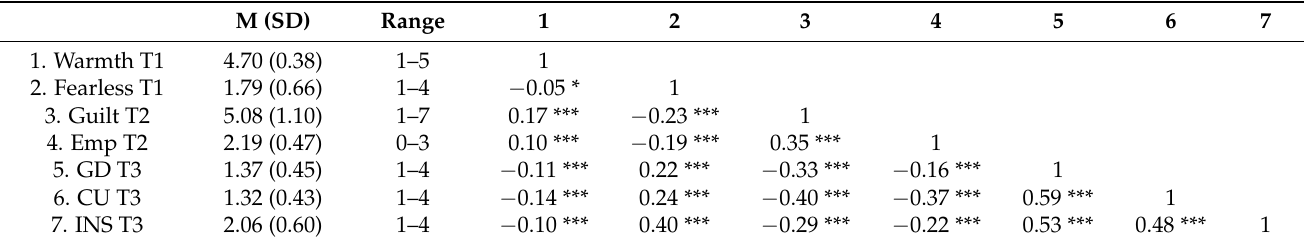
Table 1. Descriptive statistics and bivariate correlations among the study variables.